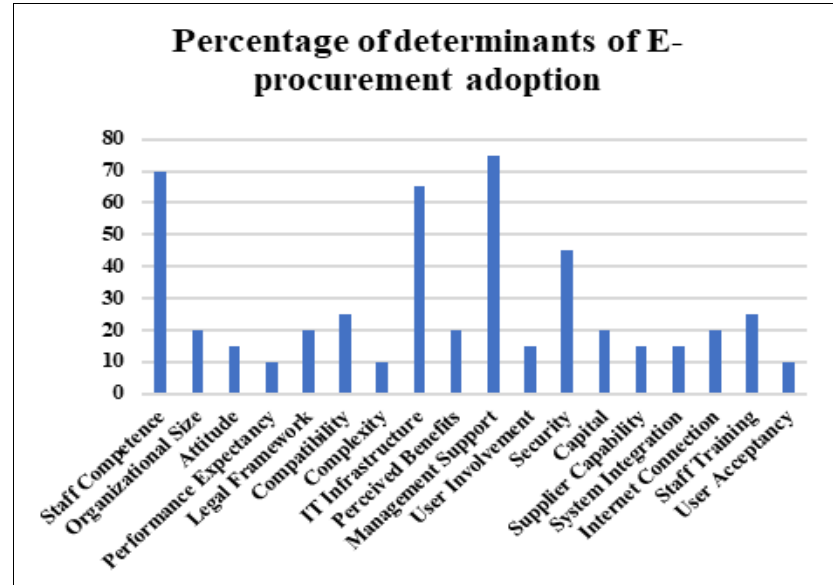
Figure 1: Percentage of determinants of E-procurement